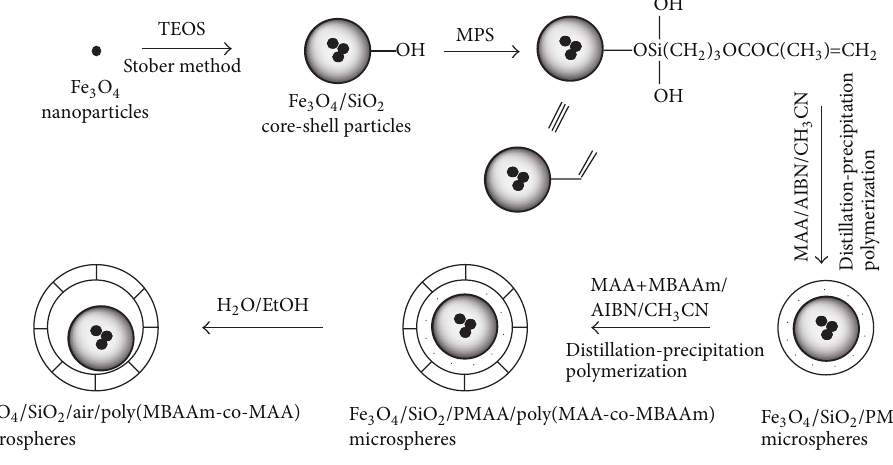
Figure 5: Preparation of pH-sensitive hollow P(MBAAm-co-MAA) microspheres with movable magnetic Fe 3 O 4 /SiO 2 cores (reproduced from [73], with permission from